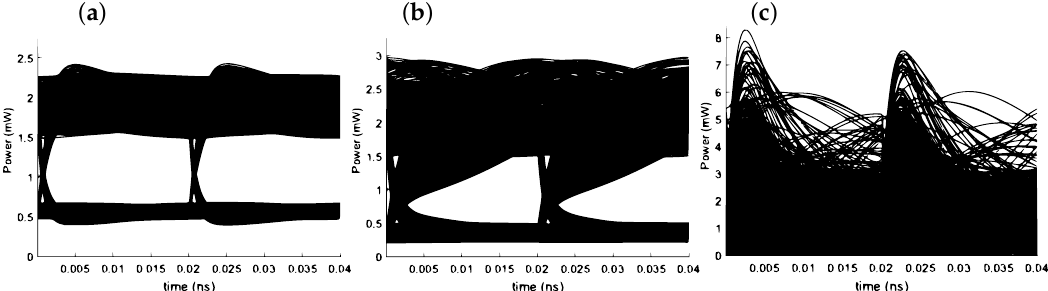
Figure 8. Eye diagrams of EAM-VCSEL output power for digital, non-return-to-zero modulation at 100 Gb/s. ( a ) d EAM = 0.5025 µ m; ( b ) d EAM = 0.501 µ m; ( c ) d EAM = 0.504 µ